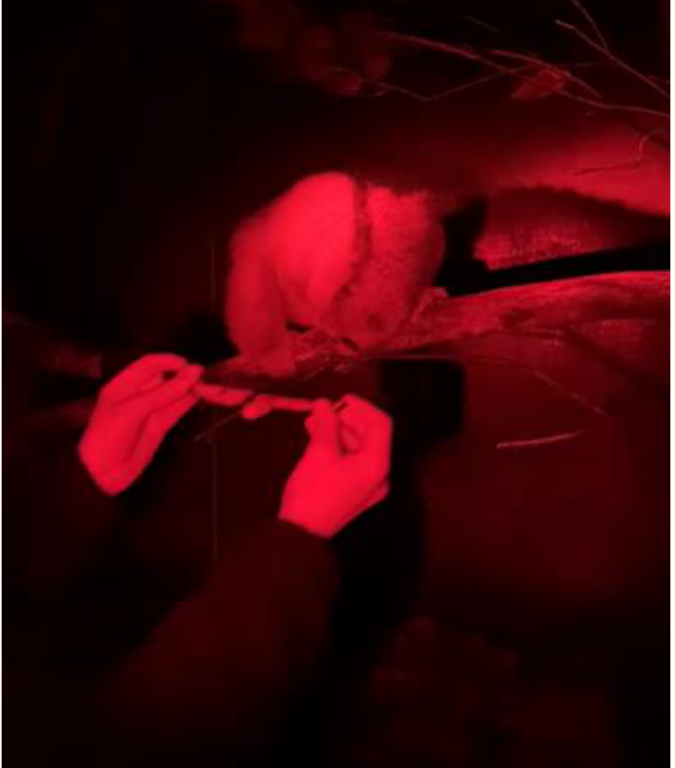
Figure 2. Tina the Bengal slow loris at the final stage of the training when we were able to safely cat collar and equip her with the accelerometer device with our hands.